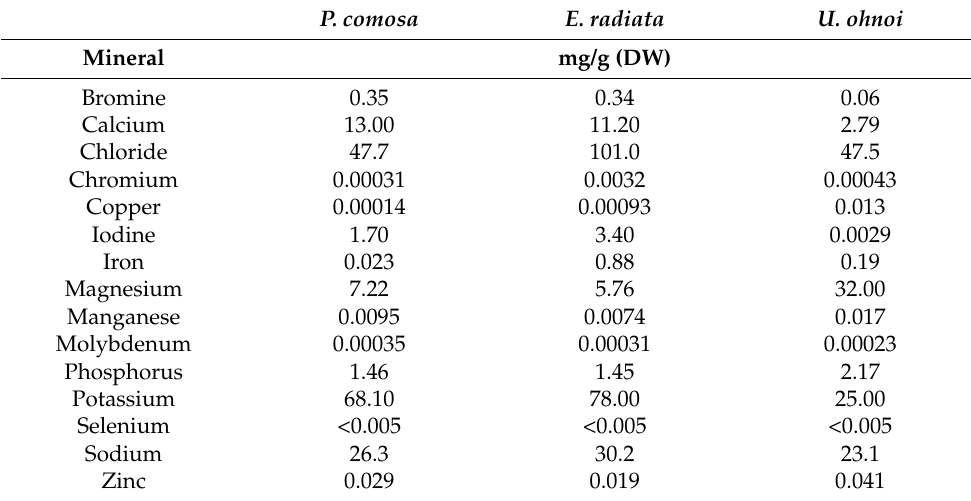
Table 4. Essential mineral content of whole seaweeds *.